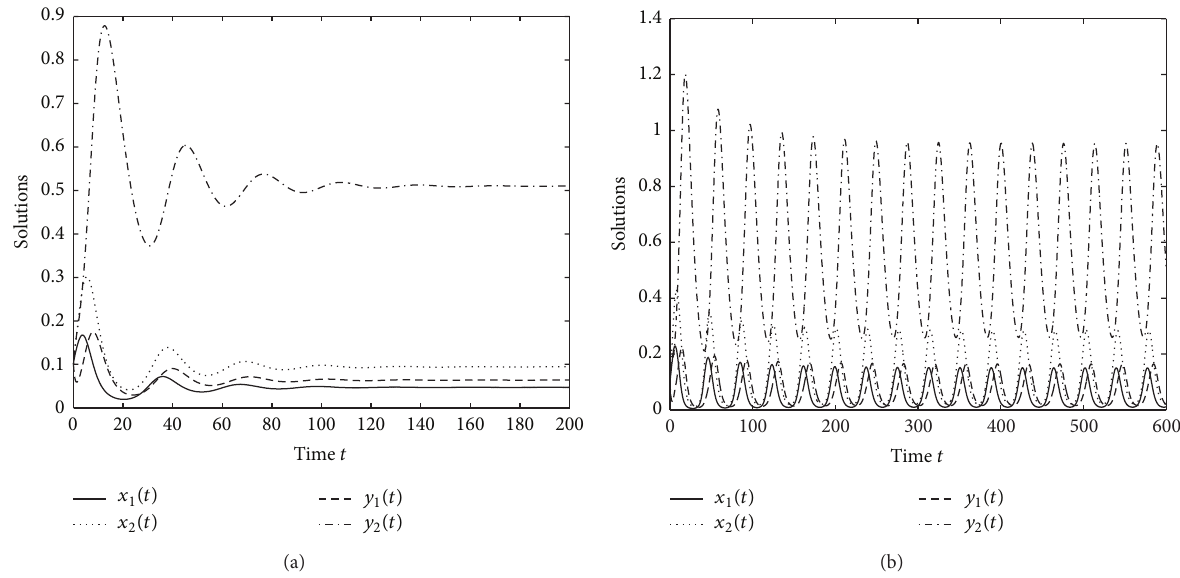
Figure 1: The temporal solution found by numerical integration of system (2) with 𝜏 = 0.1 and 𝜏 = 3 , respectively; (𝜙 1 , 𝜙 2 ,𝜑 1 ,𝜑 2 ) = (0.1, 0.1, 0.1, 0.1)